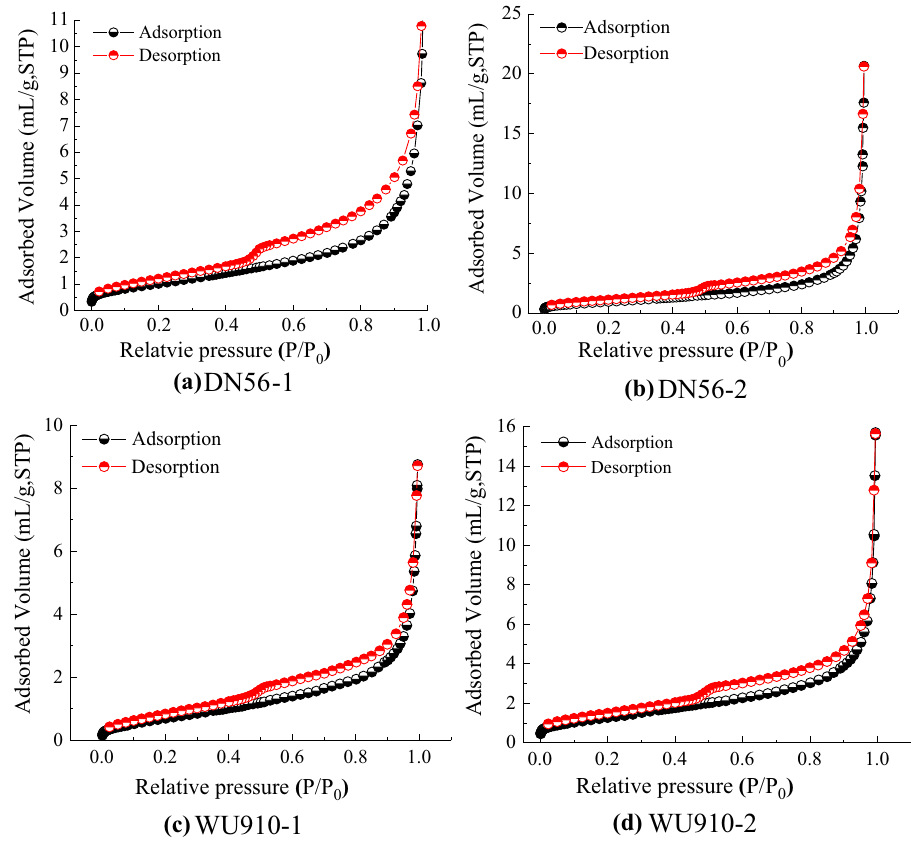
Fig. 2 Adsorption isotherms obtained by N 2